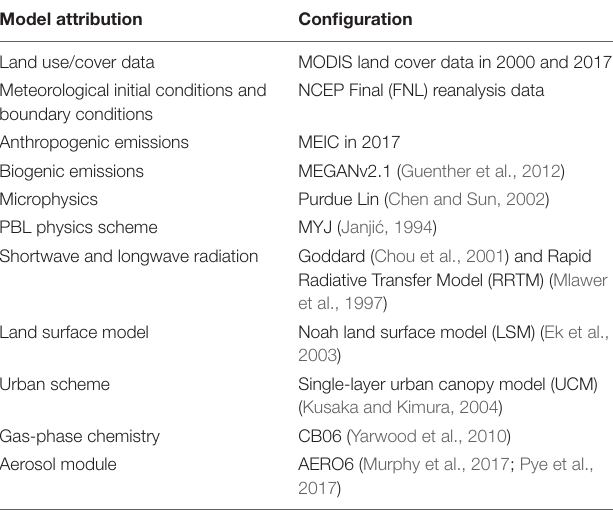
TABLE 1 | Summary of configurations in WRF-CMAQ modeling